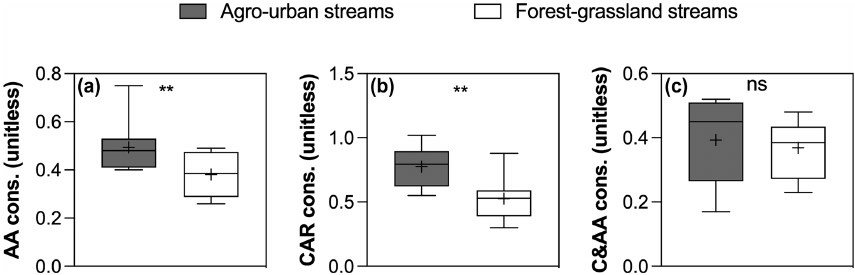
Figure 8. Boxplots of (a) AA , (b) CAR, and (c) C&AA consumption in agro-urban (grey) and forest–grassland (white) streams. The box represents the first and third quartile, the horizontal line corresponds to the median, the cross corresponds to the average, and the error bars correspond to the maximum and minimum. Mann–Whitney unpaired t tests were used to test for statistical differences: ns represents not significant, ∗= p < 0.05, ∗∗= p < 0.01, ∗∗∗= p < 0.001, ∗∗∗∗= p <